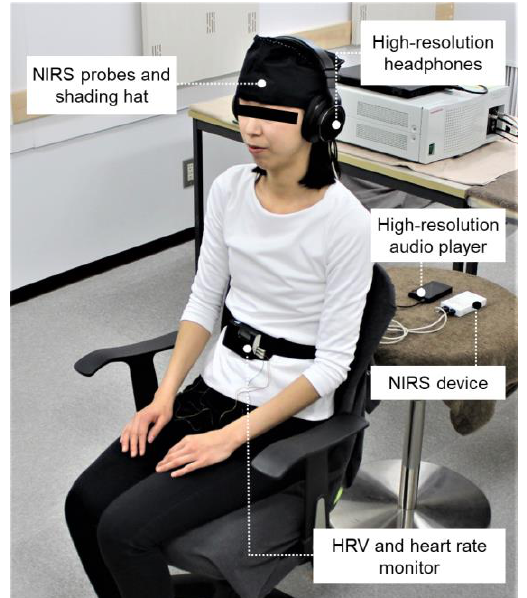
Figure 1. Experimental set-up for auditory physiological measurement. NIRS: near-infrared spectroscopy; HRV: heart rate variability.